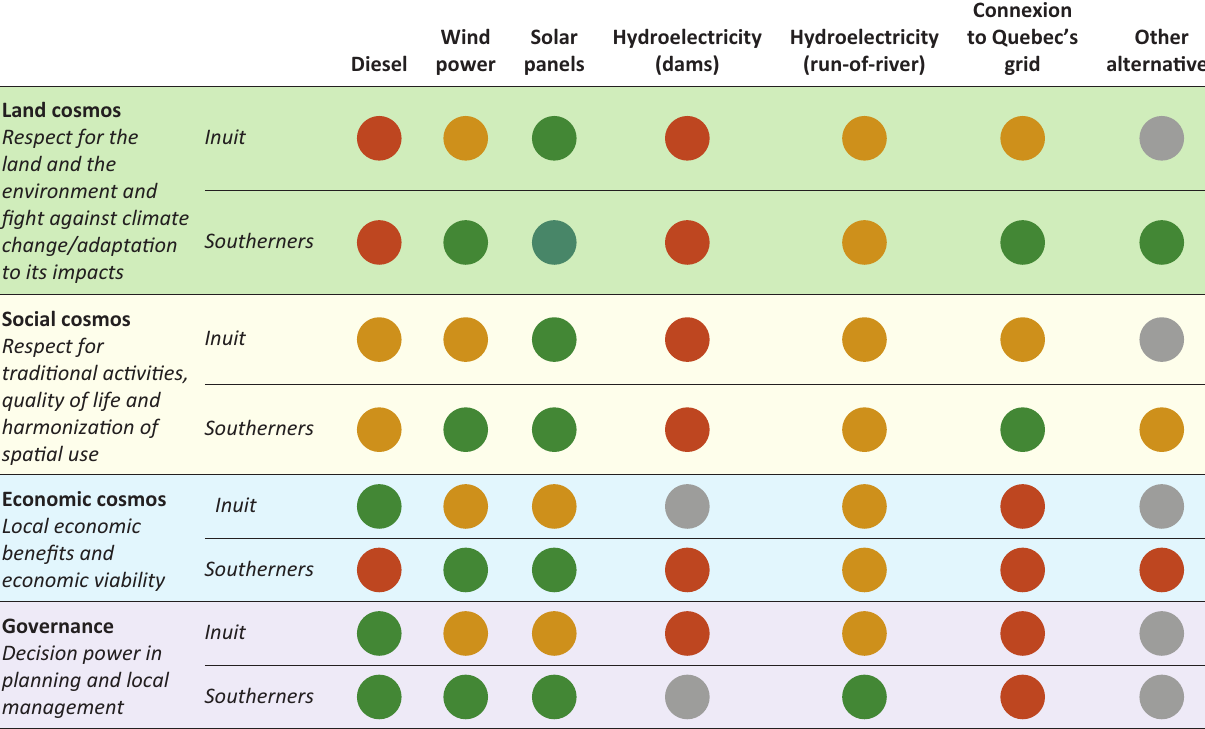
Table 2. Inuit and southerners (composed of qallunaat and organizations based in the south) interest in diesel and RET projects in Nunavik. Outcomes are color‐coded. Green: positive or neutral outcomes, yellow: moderately negative out‐ comes, red: strong negative outcomes, grey: a lack of information. Other alternatives include biomass, hydrokinetic and geothermic energy.